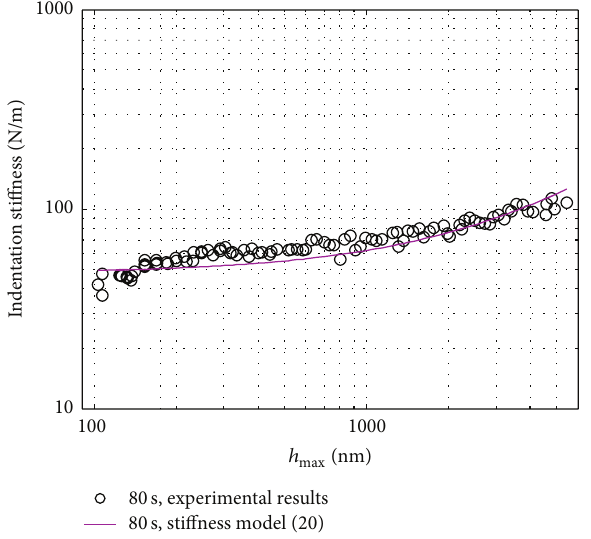
Figure 30: Comparison of the experimental stiffness 𝐾 m of PDMS obtained with a Berkovich tip with the indentation stiffness model (20) where 80s loading time was used in nanoindentation experi- ments [33].